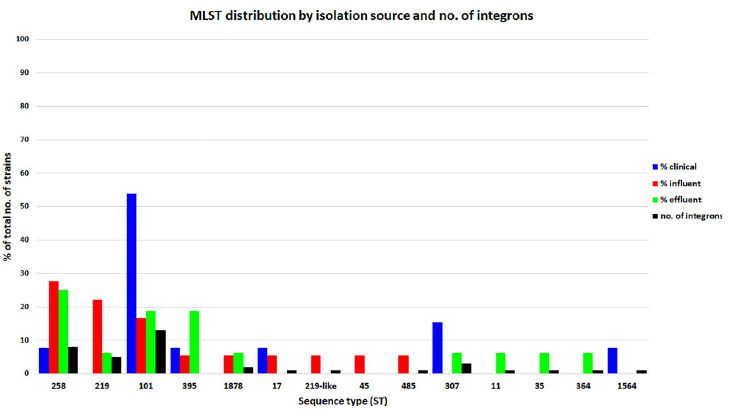
Fig 5. MLST and integrons distribution in the clinical, influent and effluent